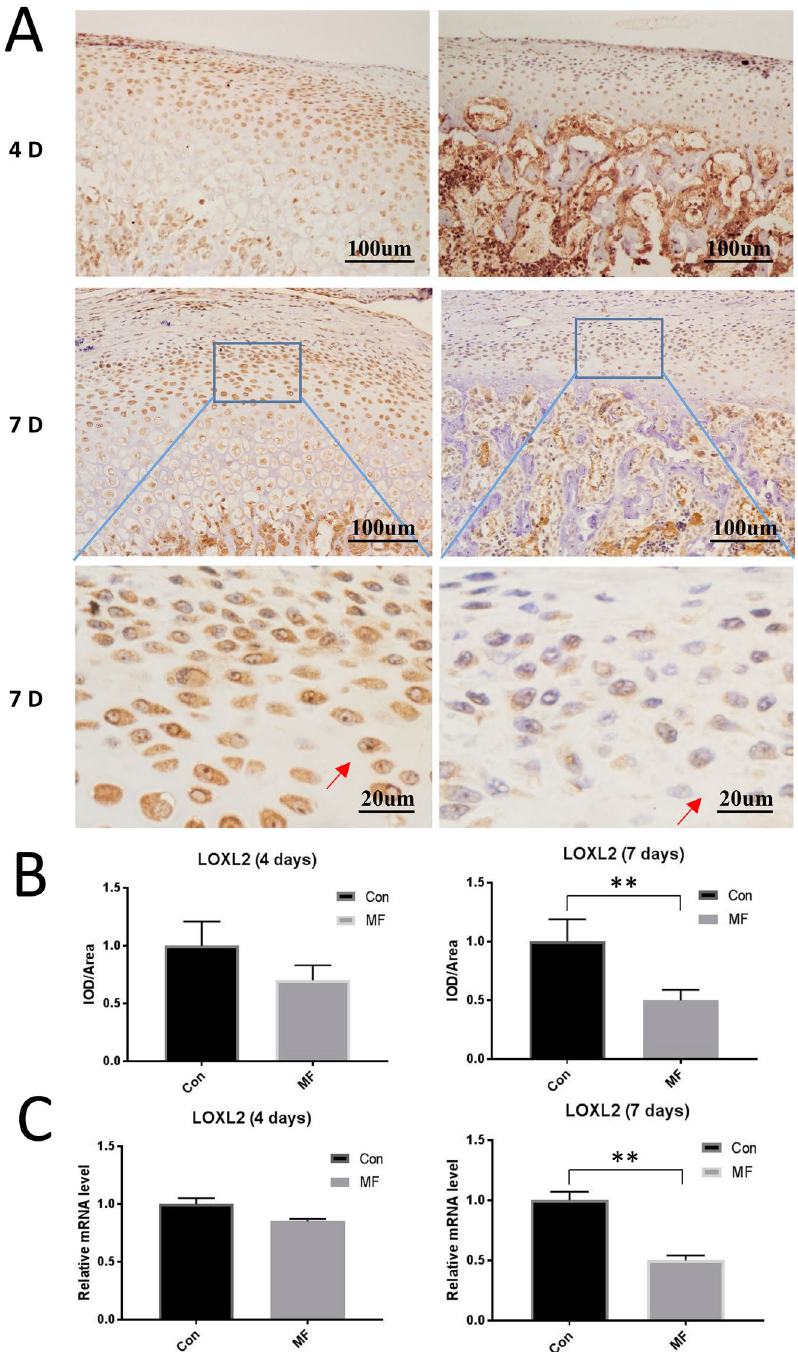
Figure 1. Decreased expression of LOXL2 was found in mechanical stress-mediated cartilage osteoarthritis. ( A ) Immunohistochemical analysis of LOXL2 expression (×100, ×400) and ( B ) quantification of it in chondrocytes from samples treated as indicated at 4 or 7 d after force application (n = 12). Chondrocytes expressing LOXL2 is denoted by arrows. ( C ) RT-qPCR analysis (n = 3) of LOXL2 expression in chondrocytes from samples treated as indicated. Error bars represent S.D. *P < 0.05 versus Con, **P < 0.01 versus